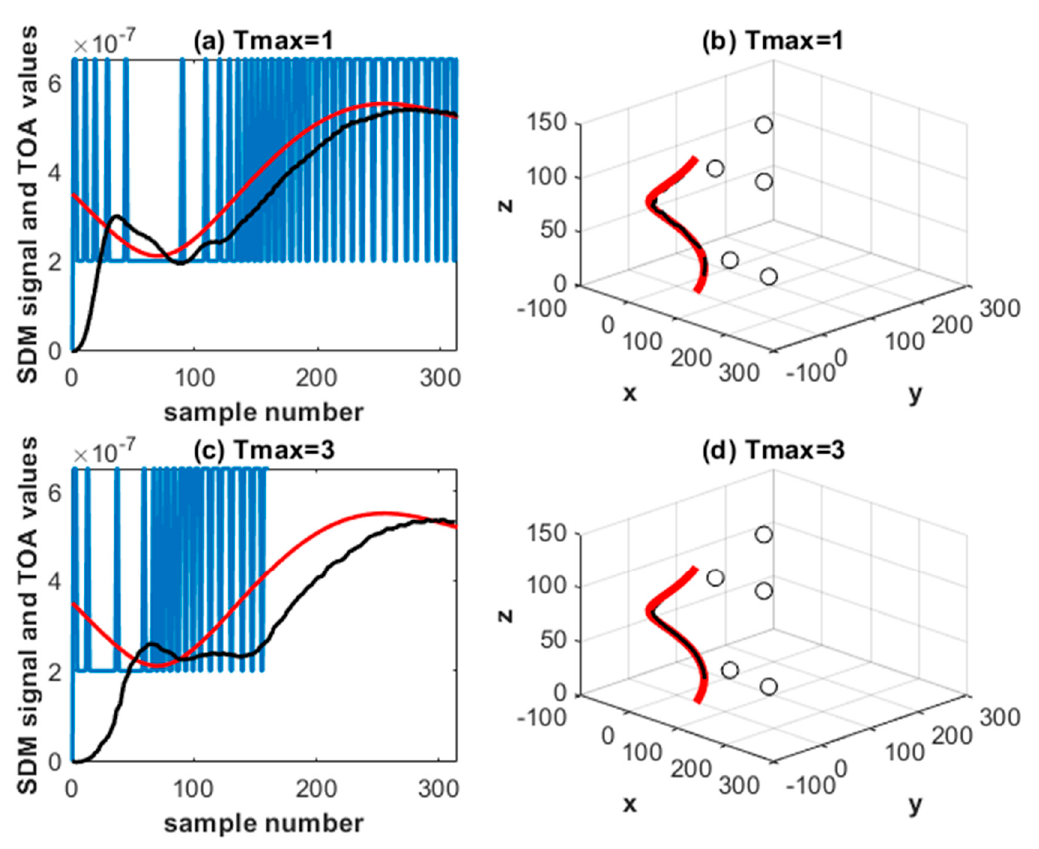
Figure 12. SDM signals, original and reconstructed TOA values and localized paths for the CS-SDM localization system. The original TOA values are shown in red and the reconstructed in black. True and localized helical paths are also shown. The true path is shown in bold red. The small circles indicate the five anchor positions. Results are averaged over 100 realizations.